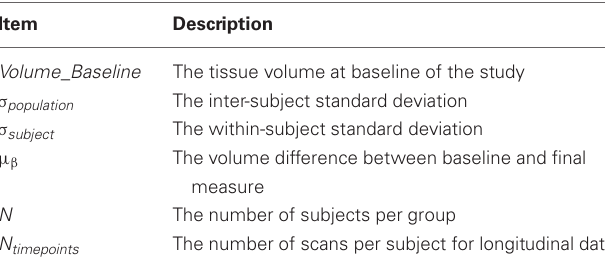
Table 1 | The key parameters in simulating change over a short period of time.